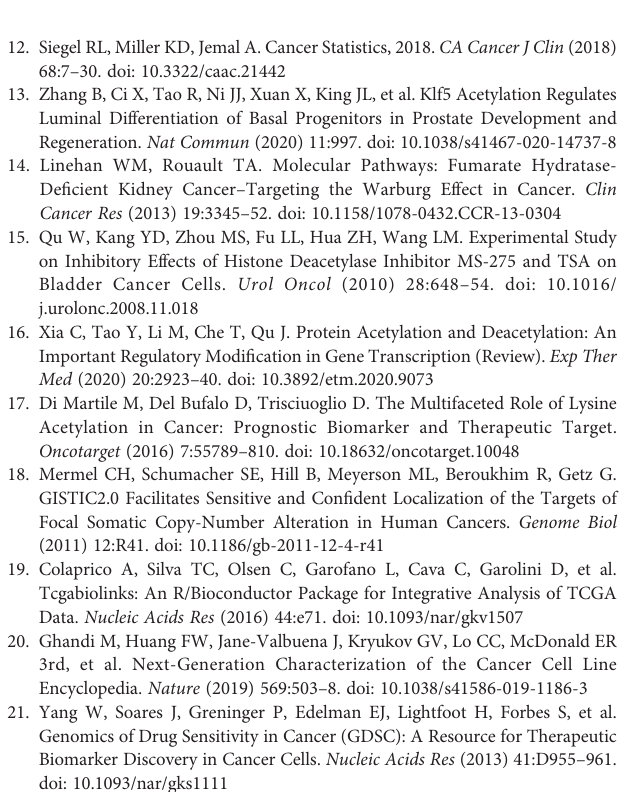
Supplementary Figure 1 | Mutation frequency distribution of lysine acetylation regulators across different urological cancer types. Left circos plot (A) showing the mutation frequency of lysine acetylation regulators in CCLE, and right circos (B) showing the mutation frequency in GDSC. Each circos represents one cancer type, which were shown in the bottom panel. *P < 0.05. Supplementary Figure 2 | CNV alterations of lysine acetylation regulators across cell lines in different urological cancer types. Left circos plot (A) showing the CNV frequency of lysine acetylation regulators in CCLE, and right circos (B) showing the CNV frequency in GDSC. Each circos represents one cancer type, which were shown in the bottom panel. Supplementary Figure 3 | (A) Immunohistochemistry images of CDK2 and SDHB in TGCT, kidney_tumor, BLCA and PRAD. Scar bar = 200um. (B, C)